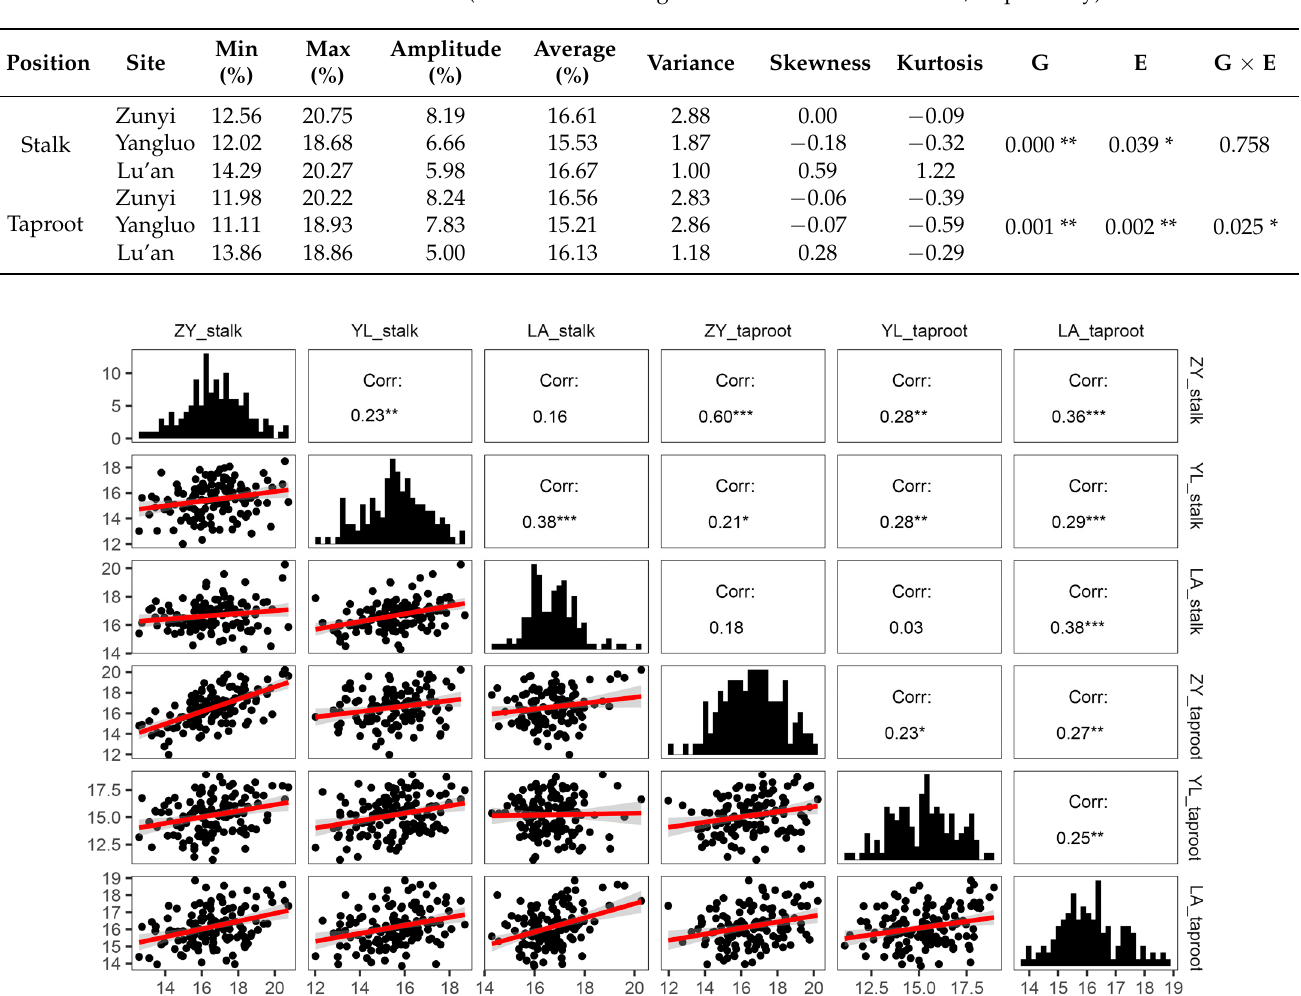
Table 1. Statistical analysis of hemicellulose content in stalk and taproot of 139 accessions of rapeseed in different environments. Significance for the effect of genotype (G), environment (E), and genotype by environment interaction (G × E) on phenotypic variance estimated by ANOVA across three environments. (*, ** and *** indicate significant levels of 0.05 and 0.01 and 0.001, respectively).